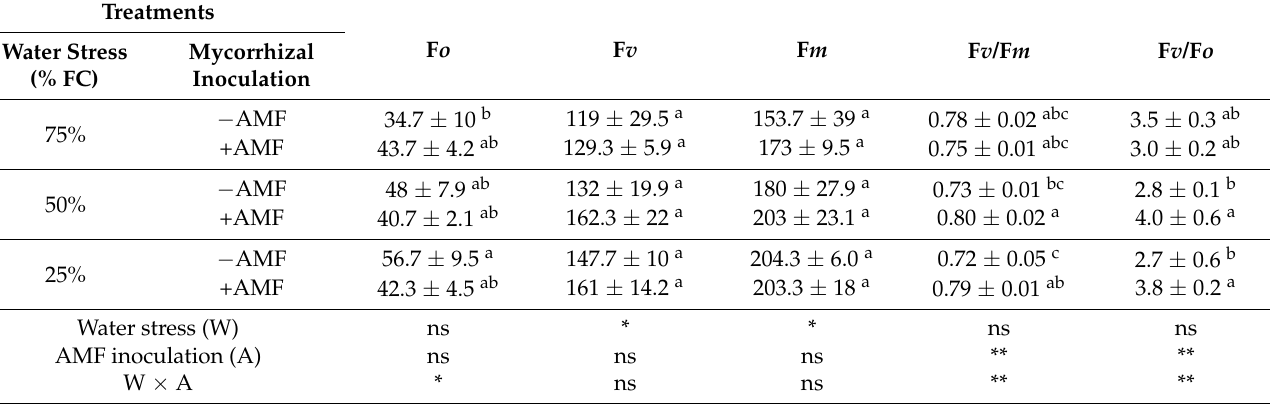
Table 4. Changes of chlorophyll fluorescence parameters in leaves of C. spinosa seedlings cultivated without ( − AMF) or with (+AMF) AMF-complex under three irrigation levels (% FC) (F o -initial fluo- rescence, F v -variable fluorescence, F m -maximum fluorescence, F v /F m -maximum quantum efficiency and F v /F o -basal quantum